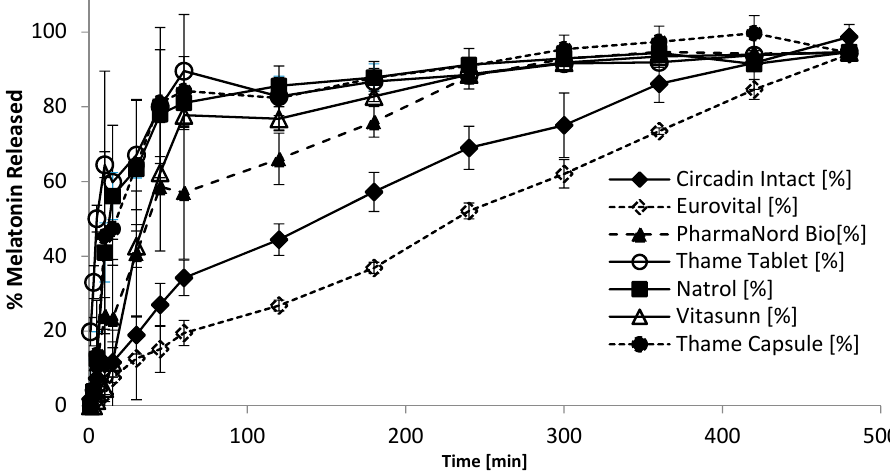
Figure 4. Comparison of dissolution profiles for melatonin tablet and capsule products (Data represent mean ± SD, n = 3).